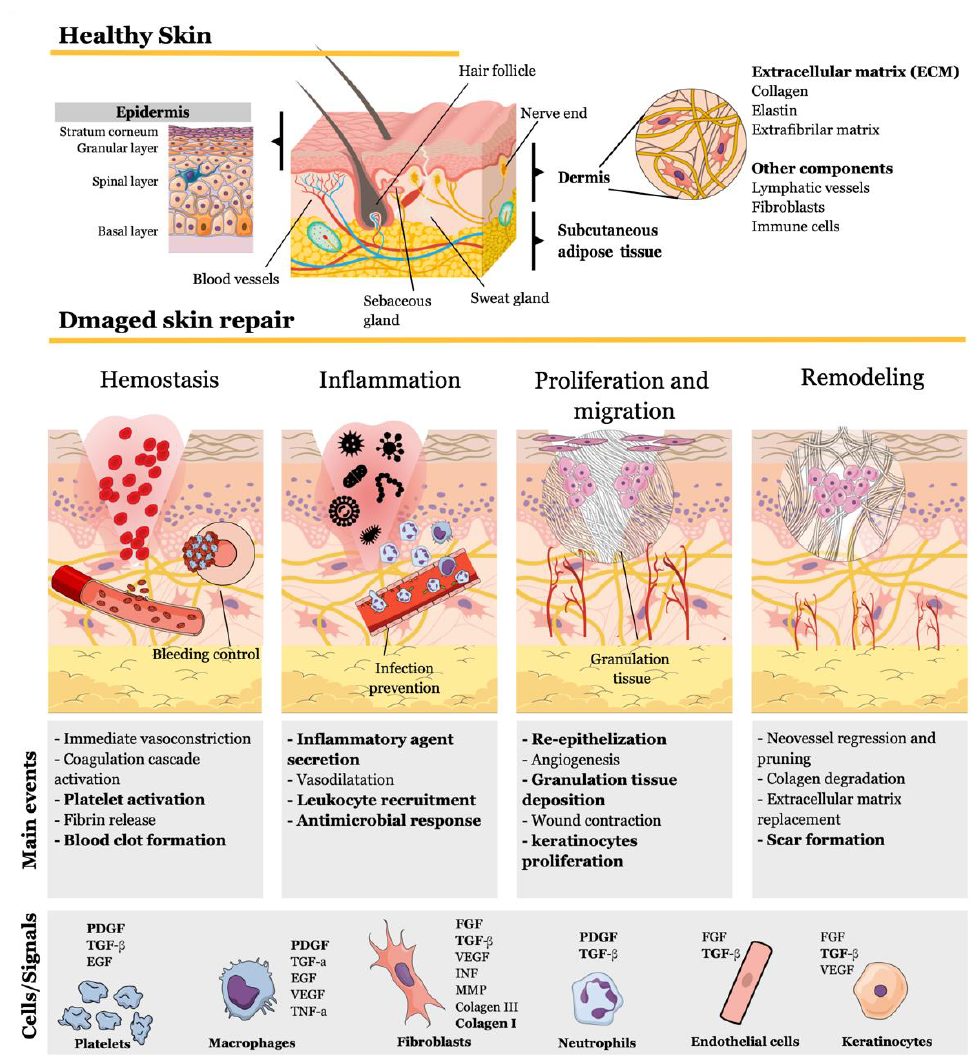
Figure 9. Main mechanisms involved in skin repair. Injured tissue naturally recovers through four subsequent and overlapping events orchestrated by mediator molecules secreted by different cell types to reconstitute skin structures and healthy tissue components. Chitosan interferes in several events (highlighted in bold) by stimulating signaling molecules. This figure compiled the mechanisms already described and was drawn using the infographic maker Mind the Graph available at https://mindthegraph.com.